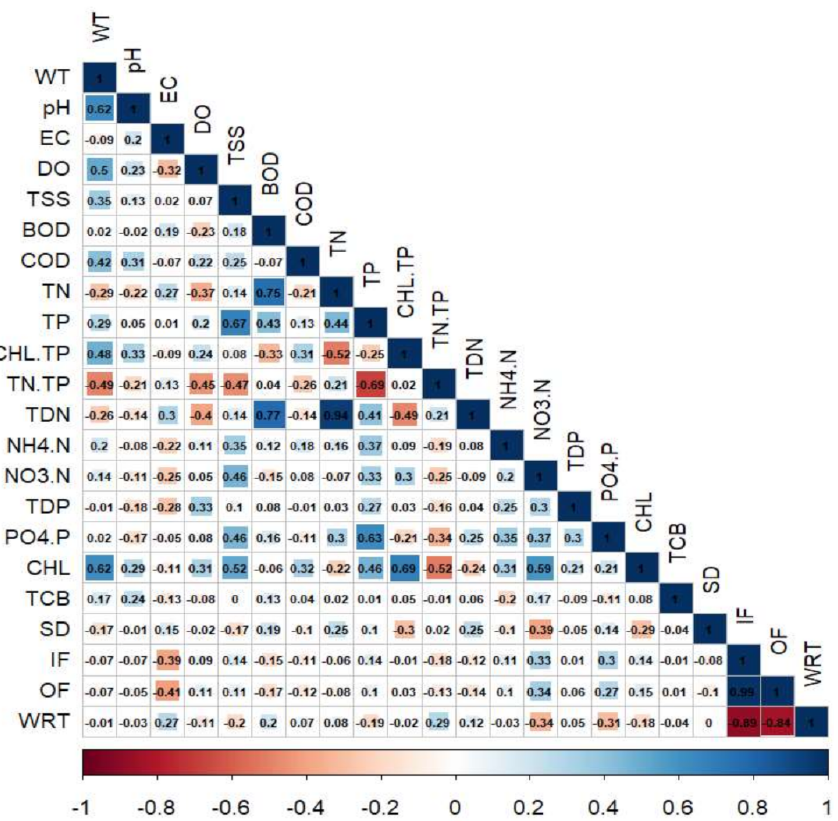
Figure 5. Pearson correlation analysis on water quality parameters during 2000–2020. WT: water temperature, pH: hydrogen ion concentration, EC: electrical conductivity, DO: dissolved oxygen, TSS: total suspended solids, BOD: biological oxygen demand, COD: chemical oxygen demand, TN: total nitrogen, TP: total phosphorus, TDN: total dissolved nitrogen, NH 4 -N: ammonium-nitrogen, NO 3 -N: nitrate-nitrogen, TDP: total dissolved phosphate, PO 4 -P: phosphate, CHL: chlorophyll, TCB: total coliform bacteria, SD: Secchi depth, IF: inflow, OF: outflow, WRT: water residence time. The graphs’ color scale is explained as red color range showing negative while blue color range positive